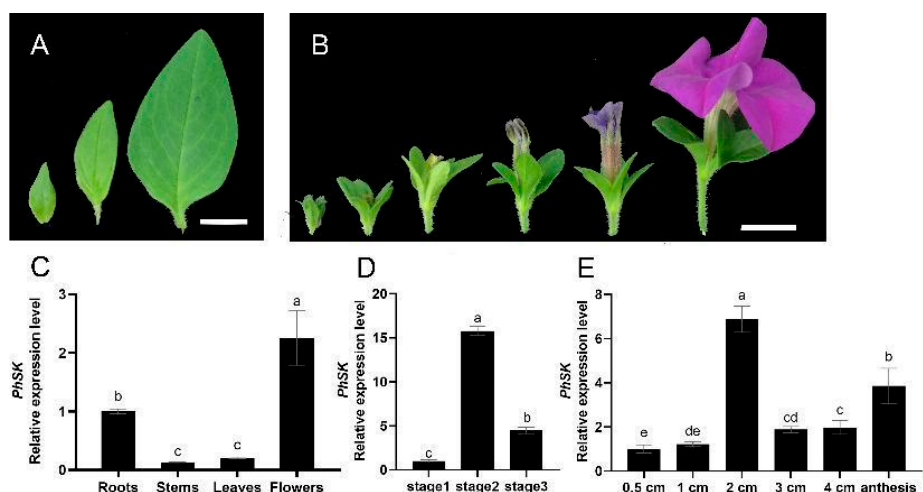
Figure 2. Expression patterns of PhSK determined by quantitative real-time PCR. ( A ) Three devel- opmental stages of petunia leaves: stage 1 (young leaves, 1.0 cm), stage 2 (growth leaves, 2.5 cm), and stage 3 (mature leaves, 4.0 cm). ( B ) Six stages of petunia flower buds: 0.5 cm, 1 cm, 2 cm, 3 cm, 4 cm, and anthesis. ( C – E ) Expression of PhSK in leaves, corollas, roots, and stems ( C ), in leaves in three stages ( D ), and in corollas during flower development ( E ). ( A ) Bar = 1 cm, ( B ) bar = 2 cm. Letters a–e mean significant differences between data sets. The datas with same letter mean non- significance. The datas with different letters mean significant differences.